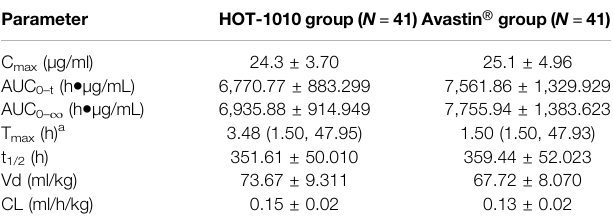
TABLE 1 | Demographics and baseline characteristics of Chinese healthy male subjects. Parameter